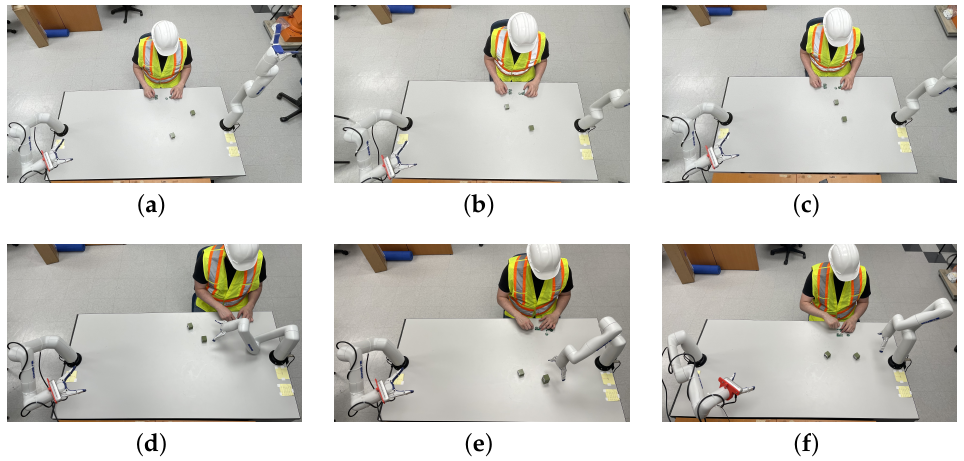
Figure 11. View of the positions of objects, operator, camera, and initial posture of the grasping manipulator for each of the six experimental scenarios; ( a – f ) show scenarios 1 to 6, respectively.